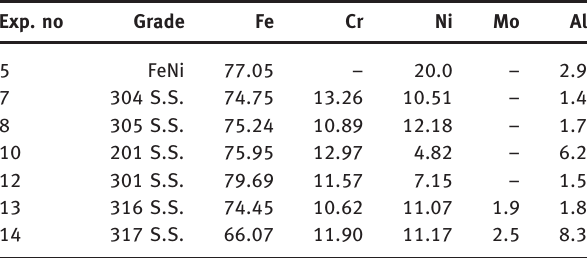
Table 5: Compositions of metallothermic process stainless steel alloys